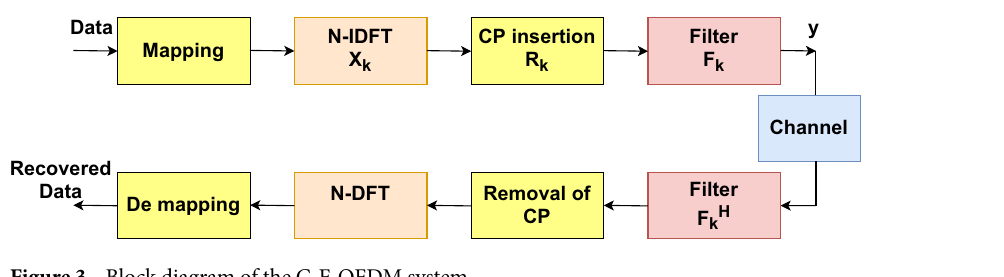
Figure 3. Block diagram of the C-F-OFDM